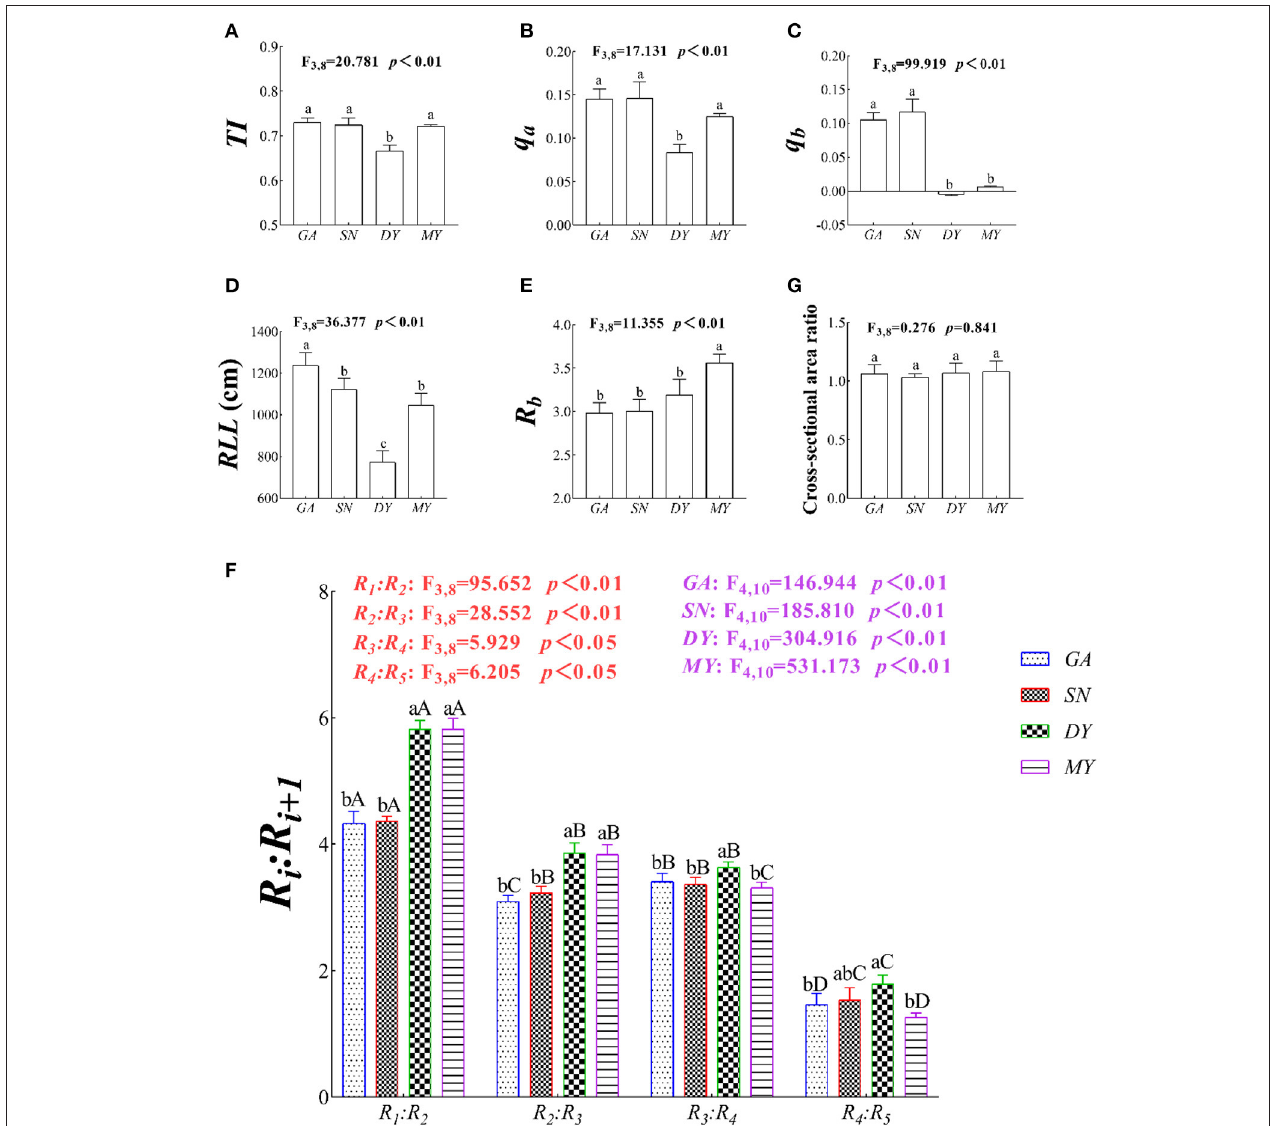
FIGURE 3 | The root system architecture (RSA) at the four test sites. DY, Deyang City; GA, Guang’an City; MY, Mianyang City; SN, Suining City. The RSA index variables are (A) TI, topological index; (B) q a and (C) q b , revised-topological index; (D) RLL, root link length; (E) R b , root branching rate; and (F) Ri:Ri + 1, gradual root branching rate. Data shown are the mean ± standard deviation (n = 3). Different lowercase letters indicated significant differences among the sites ( p < 0.05) in (A–G) . Different capital letters indicated significant differences among fine root-orders ( p < 0.05) in (F)